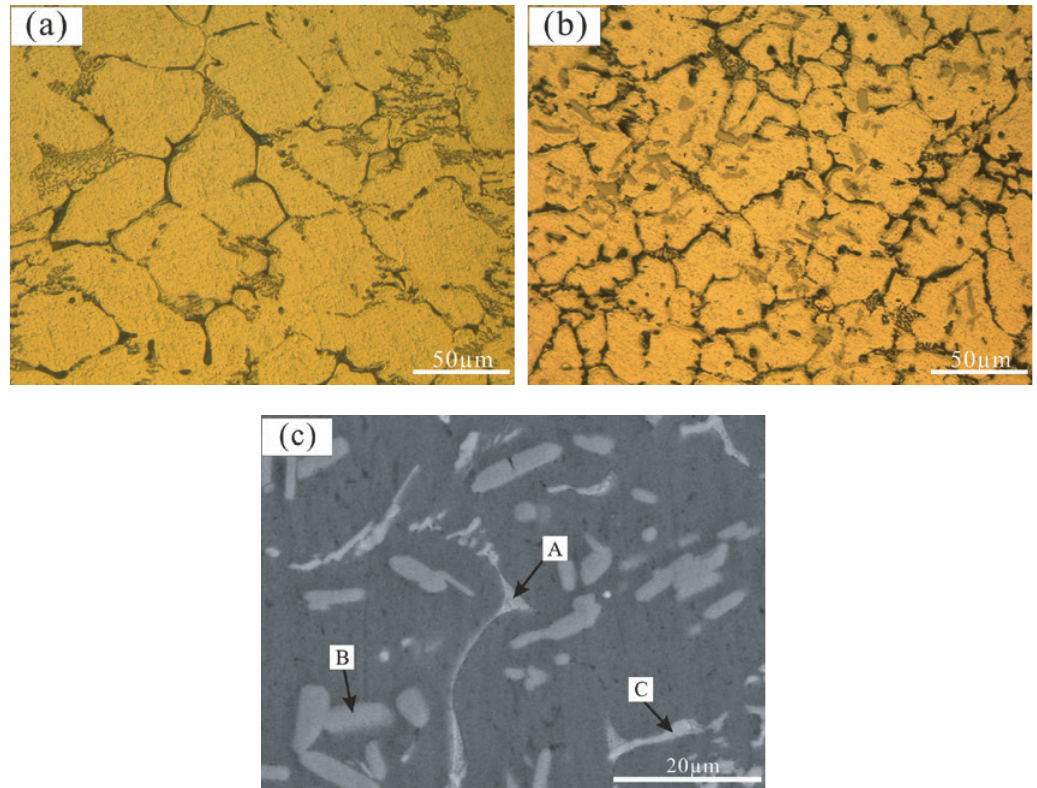
Fig. 1: Microstructures of as cast alloys: Optical microstructure of as cast alloy 2618 (a) and as cast Ti-containing alloy 2618 (b); Backscattered electron image of Ti-containing alloy 2618